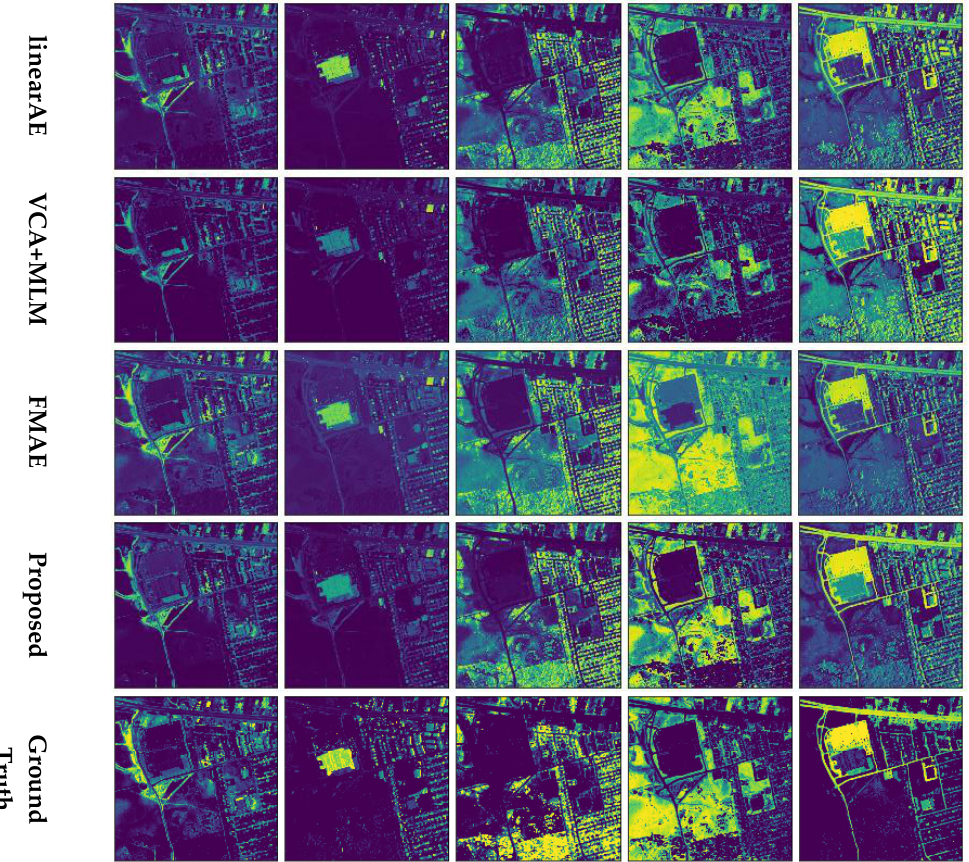
Figure 13. Estimated abundance maps for Urban. From left to right for different endmembers: dirt, roof, tree, grass and asphalt road. From top to bottom for different methods.